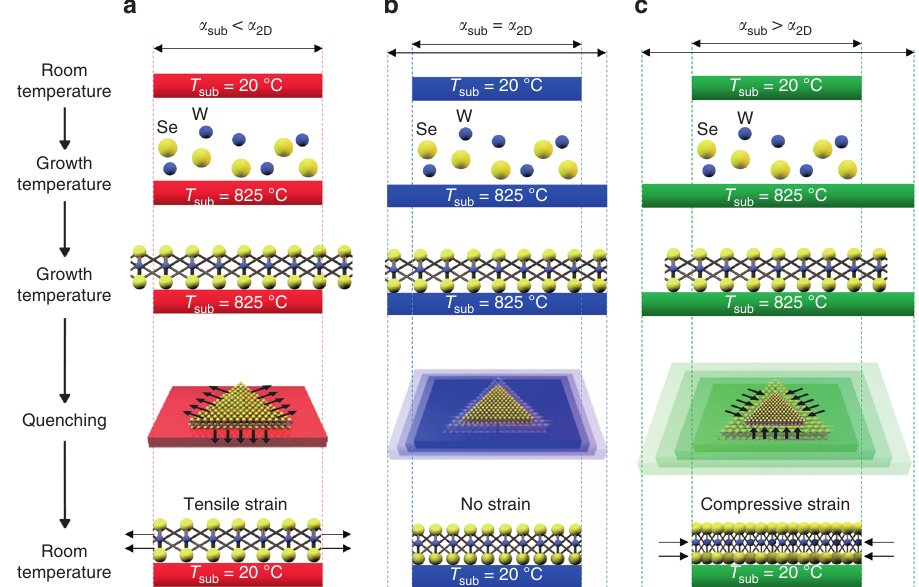
Fig. 1 Strain-engineered growth of WSe 2 using TCE-mismatch. Schematic of the process through which strain is realized during the growth of 2D materials via mismatch in substrate and TMDC thermal expansion coef fi cient. a Tensile strain is achieved when the TCE of the substrate is less than that of the 2D material, b relaxed samples are achieved when the TCE of the substrate and 2D material match, and c compressive strain is achieved when the TCE of the substrate is greater than that of the 2D